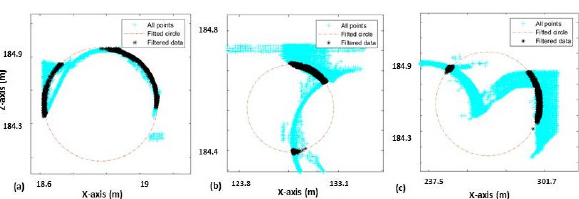
Figure 18. Sample locations where correct roller locations were identified but incorrect parameters were computed. (a) Outlier points on the left side of the roller. This resulted in a larger diameter radius and lower Z-coordinate of the center, (b) and (c) part of the roller selected resulting in incorrect parameters.